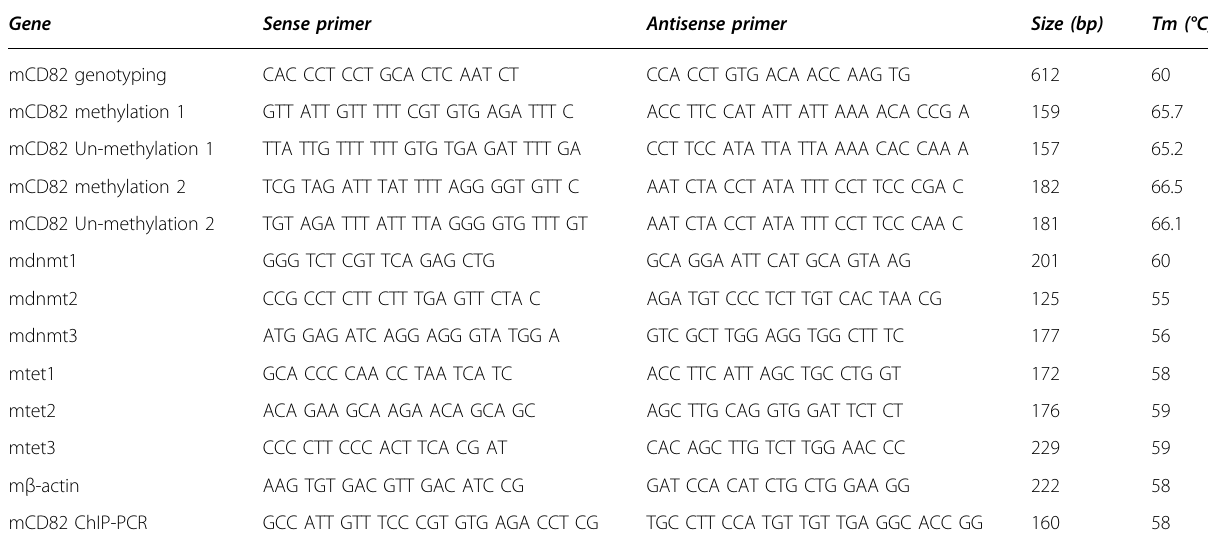
Table 1 Primers used in this study